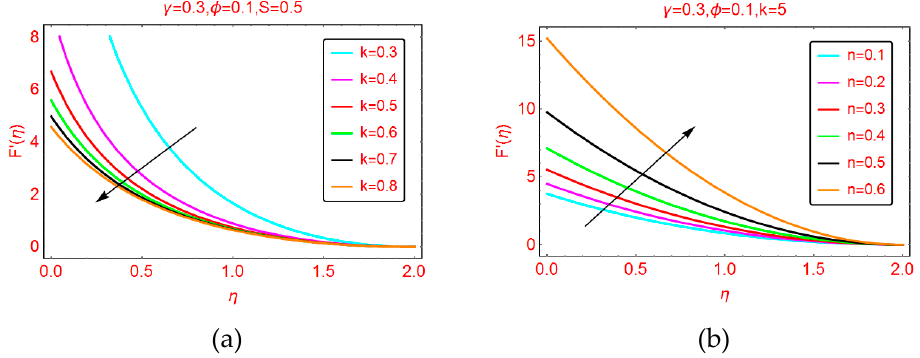
Figure 2. The velocity distribution for varying ( a ) k and ( b ) n .